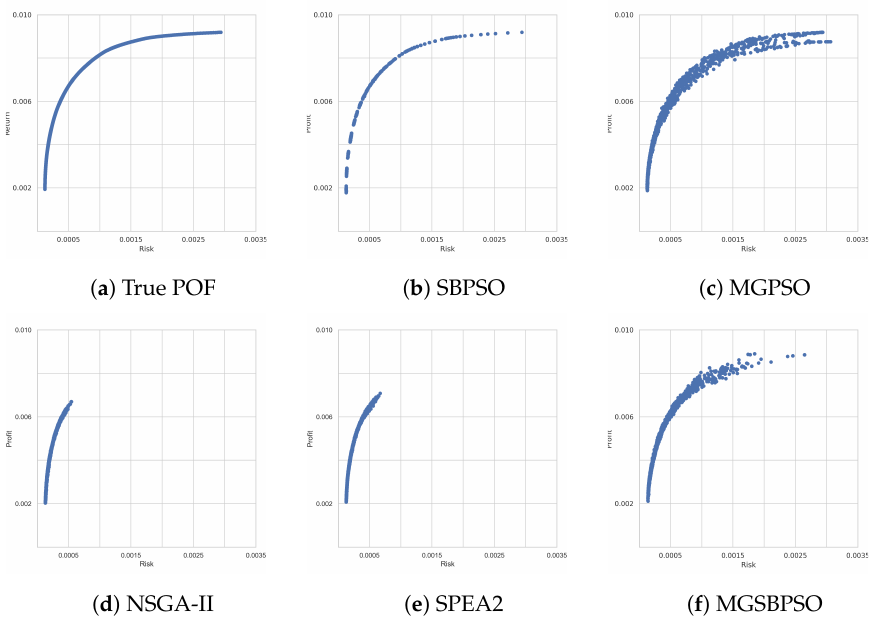
Figure 6. Pareto-optimal fronts obtained for S&P 100.